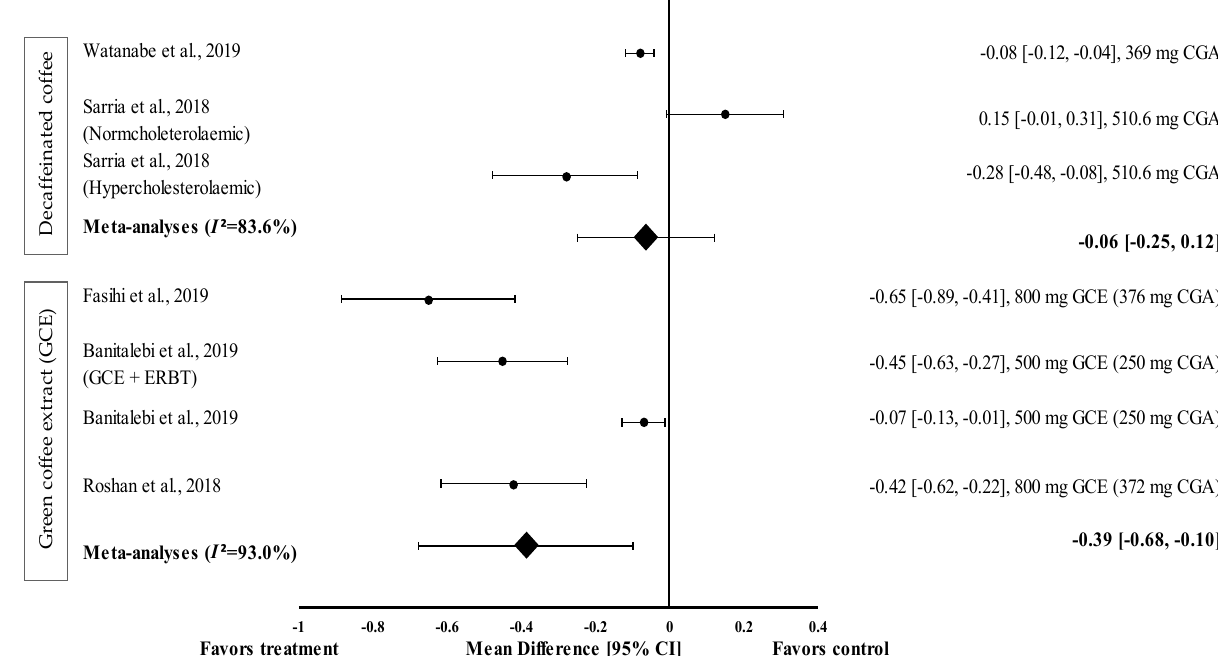
Figure 2. Forest plot showing the effect of decaffeinated coffee and GCE on waist circumference, expressed as mean differences between the values obtained from the intervention and control groups. A negative effect size indicates that decaffeinated coffee and GCE supplements reduce waist circumference. Meanwhile, a positive effect size indicates that decaffeinated coffee increases waist circumference. Horizontal lines represent 95% CIs. Diamonds represent the pooled effect size from the random effect analysis. CGA: chlorogenic acid, CI: confidence interval, ERBT: elastic resistance band training, GCE: green coffee extract. The values ± 0.2, ± 0.5 and ± 0.8 represent small, medium, and large effect sizes [22,26,29–31].